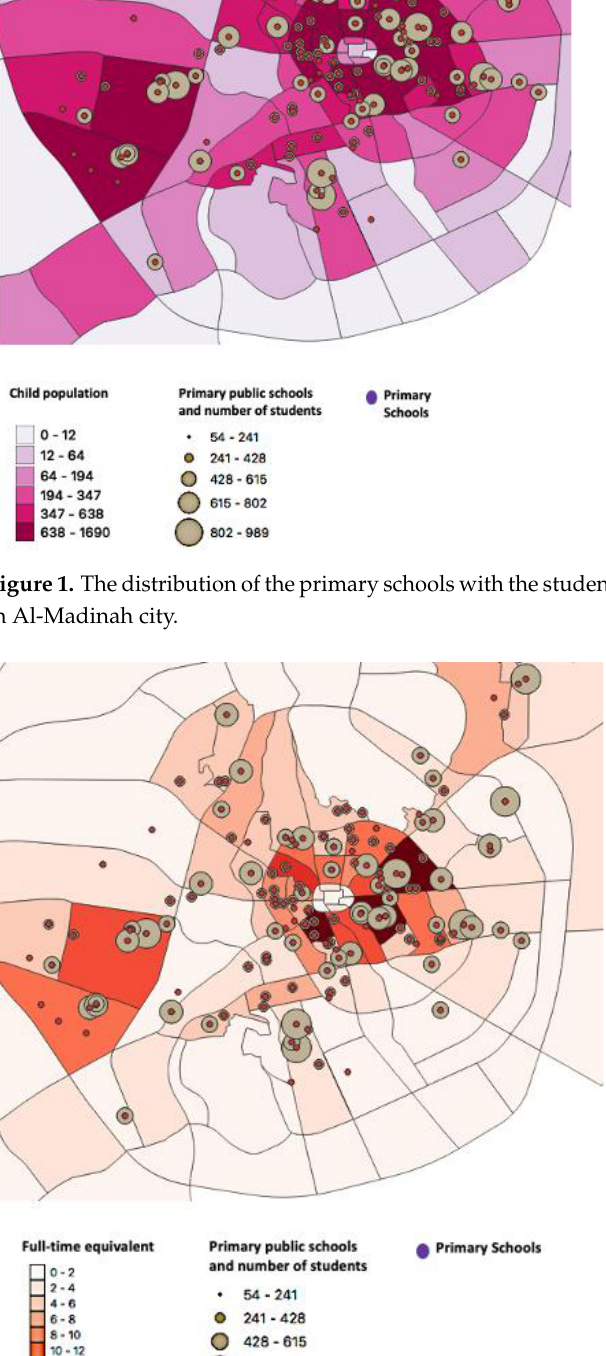
Table 1. The number of dentists required for school dental services presented in 2 models for Al- Madinah: